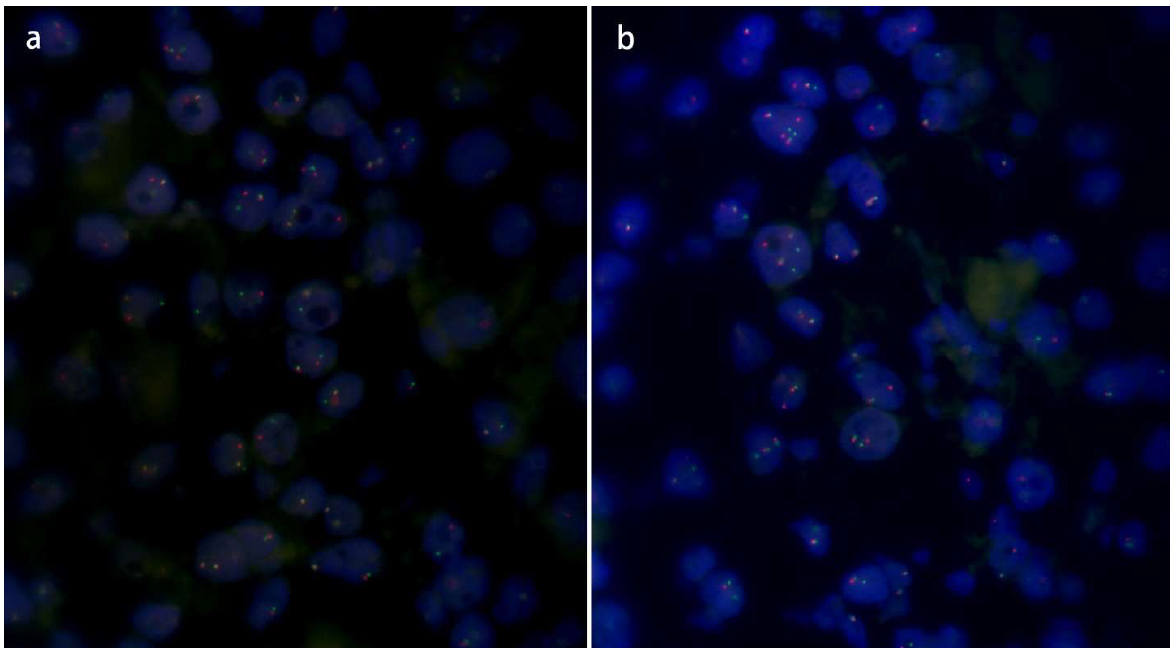
Figure 5. FISH results of the TFEB rearranged RCC. TFEB break apart FISH showed TFEB genomic rearrangement (separated red and green signals) ( a ). In two tumors (cases four and ten) the coinci- dence of TFEB gene copy number gains were observed (three to five fluorescent signals per neoplastic nuclei) ( b ).